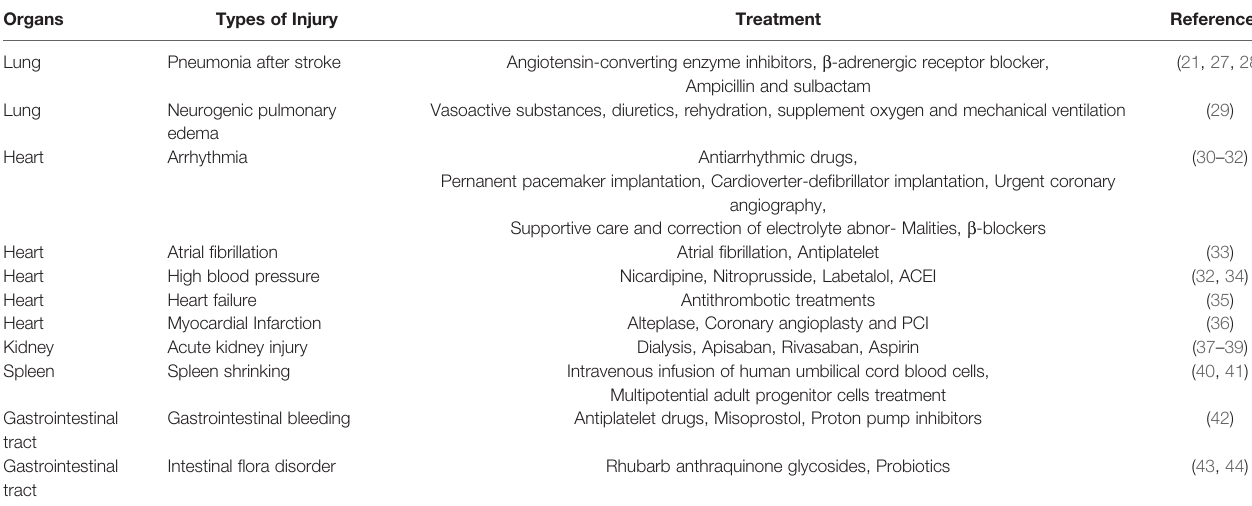
TABLE 1 | Injury types and treatment of different organs after stroke. Organs